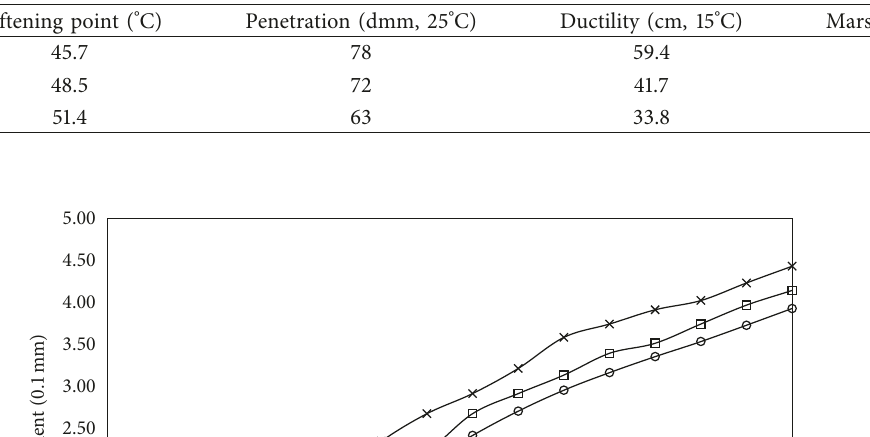
Figure 6: Dynamic behavior of KNN element in the asphalt concrete under different Table 2: Properties of bitumen and asphalt samples with different ageing.